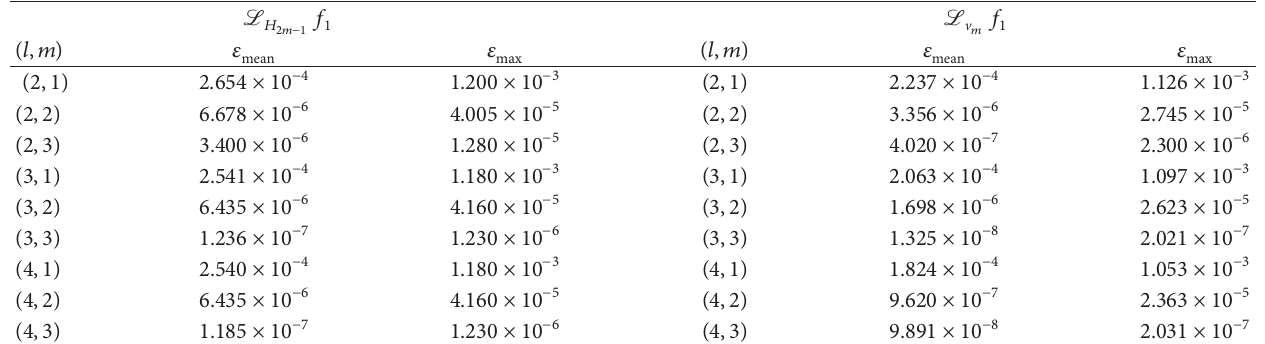
and L V for the saddle 2𝑚−1 𝑚